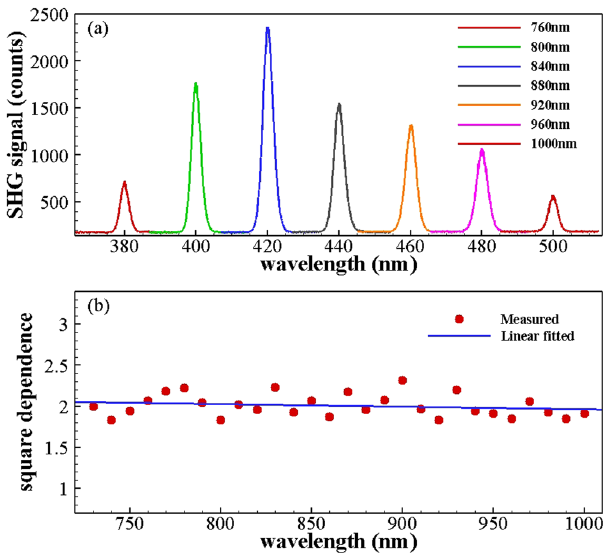
Figure 3. ( a ) SHG at a range of discrete FW wavelengths with constant FW power of 4.07 mW. ( b ) Square power dependence of the SHG signal on the FW laser demonstrated at each discrete FW wavelength from 730 nm to 1000